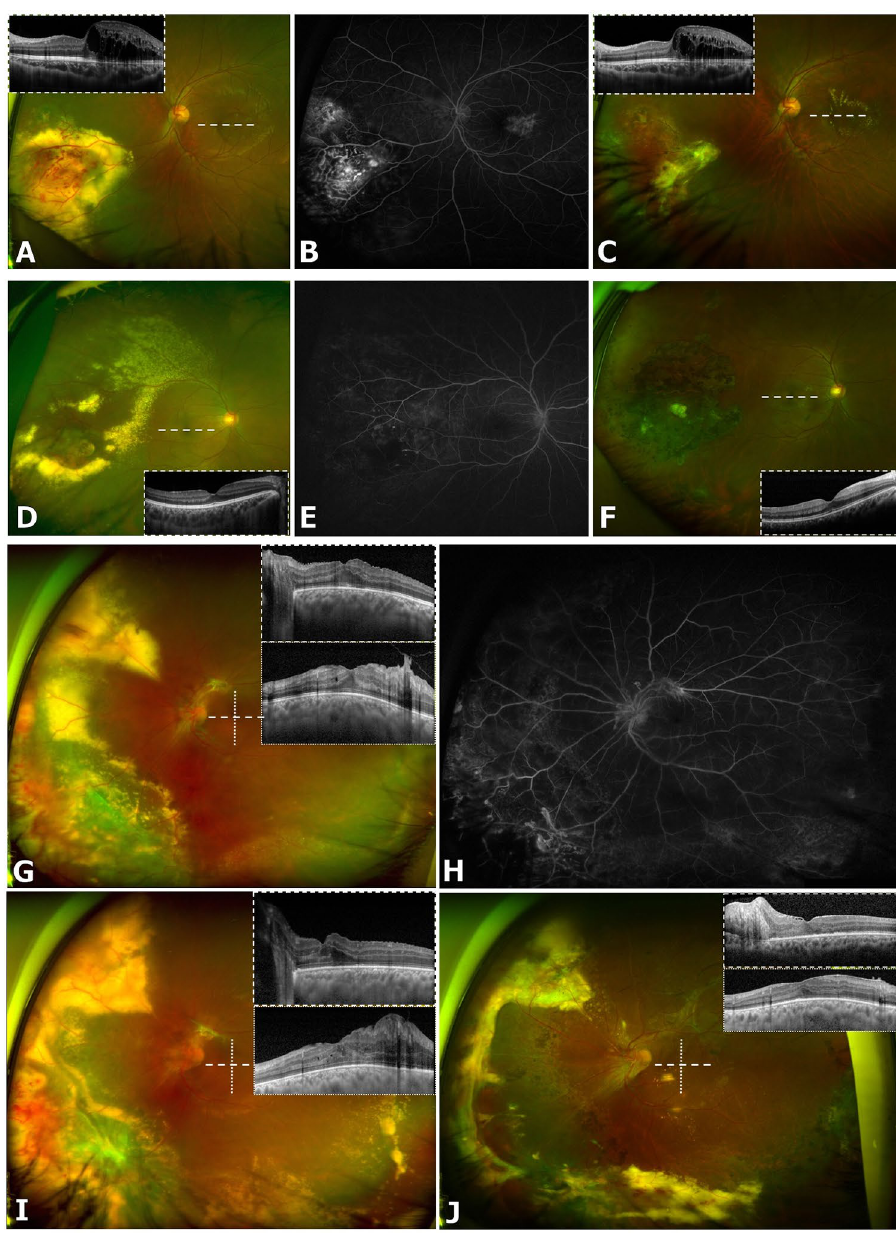
Figure 1. Ophthalmic imaging findings in representative cases of patients with Coats’ disease treated with a combination of laser ablation and anti-vascular endothelial growth factor (anti-VEGF) injections. Case 1 ( A – C ): A 14-year-old boy with no prior medical history presented with decreased vision in his left eye beginning one month prior to presentation. ( A ) Retinal telangiectasias with exudates involving two clock hours in the inferonasal quadrant, as well as retinal thickening in the temporal macula, were noted on ultra-widefield fundus photography and optical coherence tomography (OCT) imaging (inlet). ( B ) Fluorescein angiography showed multiple polyps and late leakage in the corresponding areas. ( C ) After a combination of six anti-VEGF injections and three laser sessions (including a macular focal laser), the peripheral lesions were stable on ultra-widefield fundus photography, though persistent exudative leakage was present in the macula on OCT. Case 2 ( D – F ): A man in his early thirties presented with floaters in his right eye and was diagnosed with Coats’ disease after review of ultra-widefield fundus photography ( D ), OCT ( D , inlet), and fluorescein angiography ( E ). This patient underwent a combination of two laser sessions and three anti-VEGF injections. ( F ) Three years later, the patient was in a stable condition with no signs of disease reactivation or recurrence on ultra-widefield fundus photography and OCT (inlet). Case 3 ( G – J ): A 20-year-old was diagnosed with Coats’ disease, based on the peripheral lesions on ultra-widefield fundus photography ( G ) and OCT (inlet), as well as fluorescein angiography ( H ). A combination of two laser sessions and two anti-VEGF injections were performed in this patient. ( I ) Unfortunately, progression of both macular fibrosis with traction and peripheral exudation were observed, and the patient underwent vitrectomy for removal of vitreoretinal fibrotic membranes. ( J ) At 1-year post-vitrectomy, there were no signs of disease recurrence or reactivation, although vitreoretinal fibrosis was observed in the superior